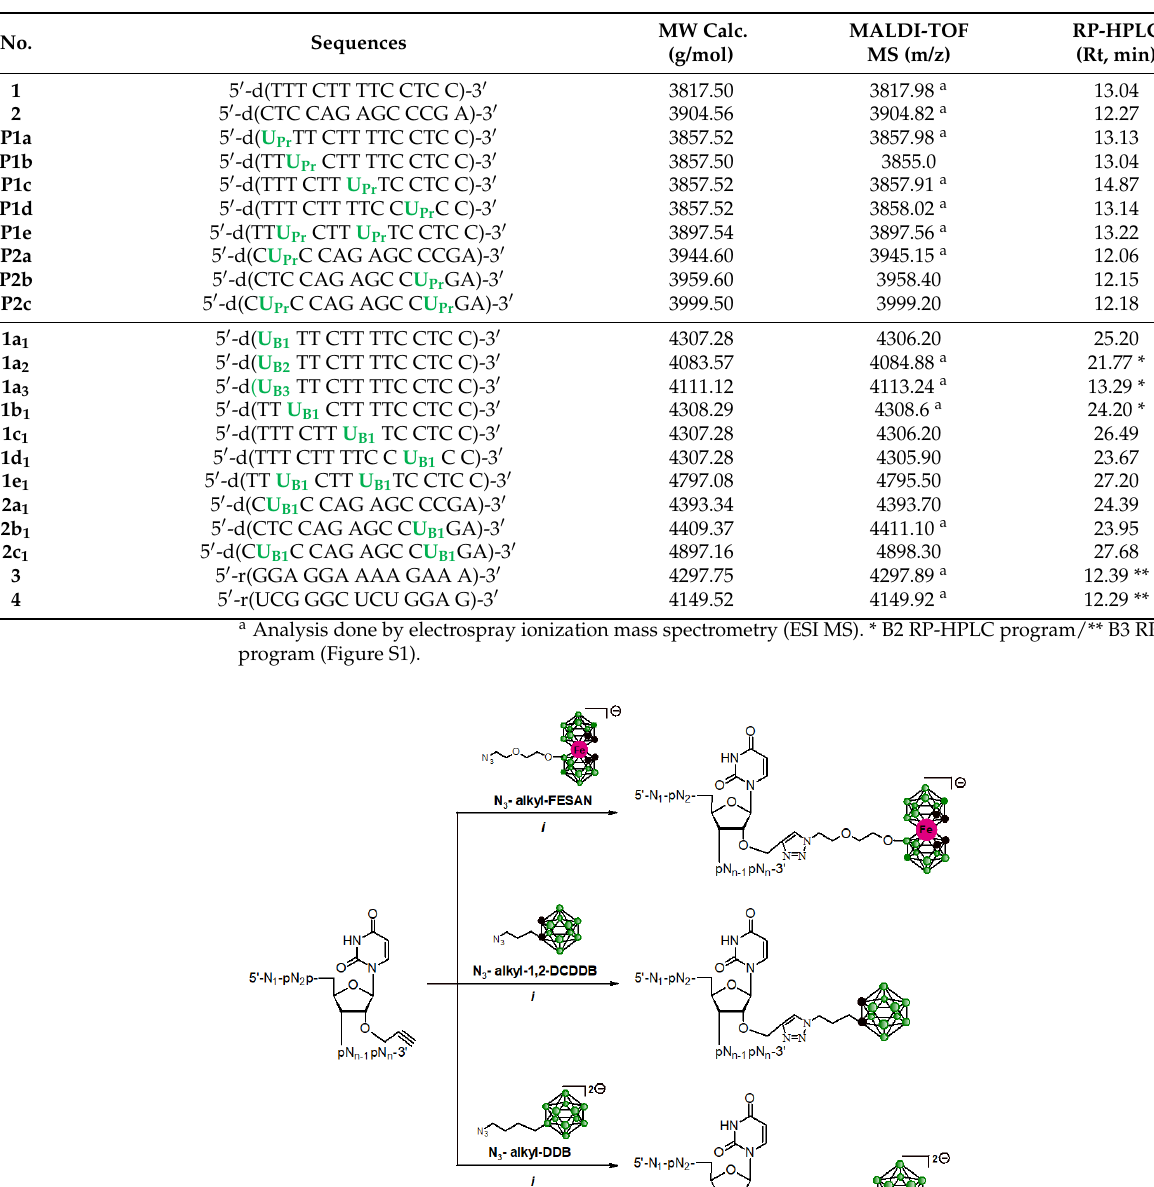
Table 1. Sequences, molecular mass, and reversed-phase high-performance liquid chromatogra- phy (RP-HPLC) data for the oligonucleotide substrates and products used in these studies. The U Pr and U B1 , U B2 , U B3 stand for a 2 (cid:48) - O -propargyl uridine or boron clusters ([(3,3 (cid:48) -Iron-1,2,1 (cid:48) ,2 (cid:48)